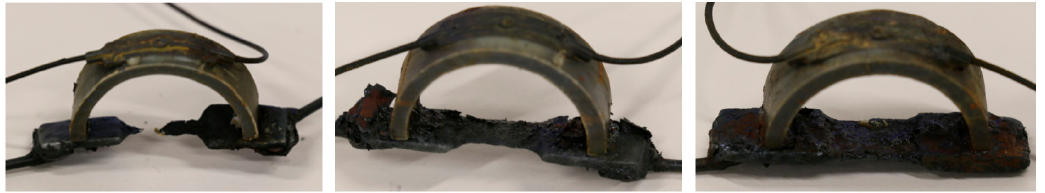
Figure 14. The three corrosion sensors after accelerated corrosion failure.